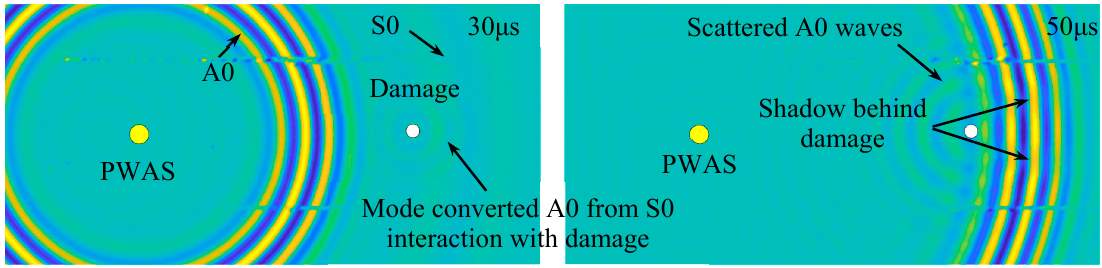
Figure 6. Spatial wavefield in the aluminum plate with simulated corrosion damage, showing S0 mode and A0 mode waves interacting with the corrosion damage.